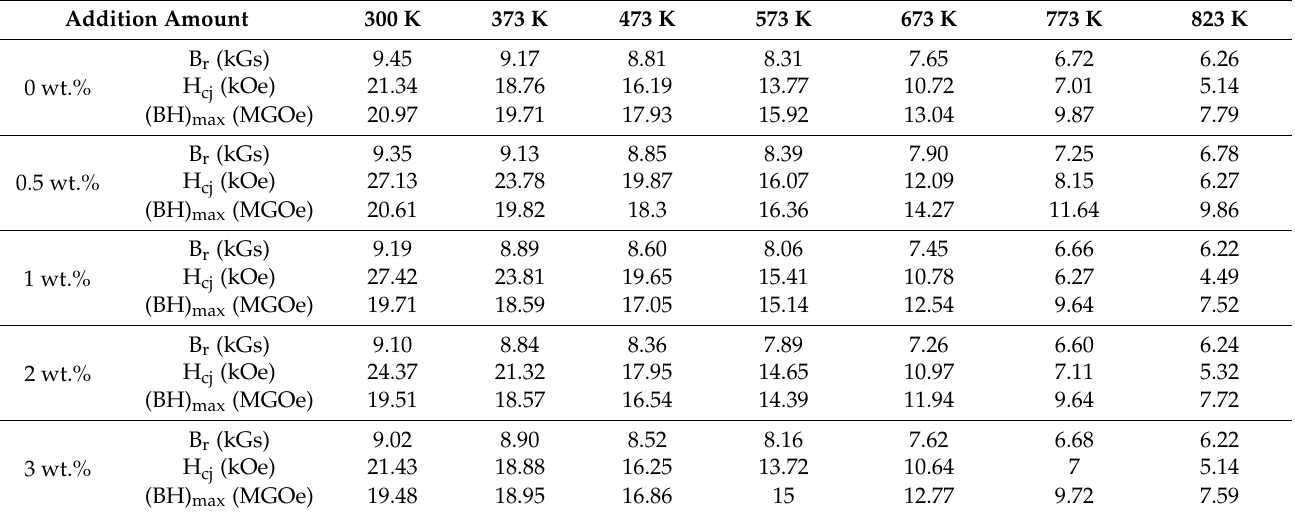
Figure 1. The demagnetization curves of magnets doped with different amounts of Y 2 O 3 at room temperature ( a ); the H cj variation of magnets with 0 wt.%, 0.5 wt.% and 2 wt.% addition from 300 K to 823 K ( b ). Table 1. The magnetic properties of magnets doped with different amounts of Y 2 O 3 from 300 K to 823 K.